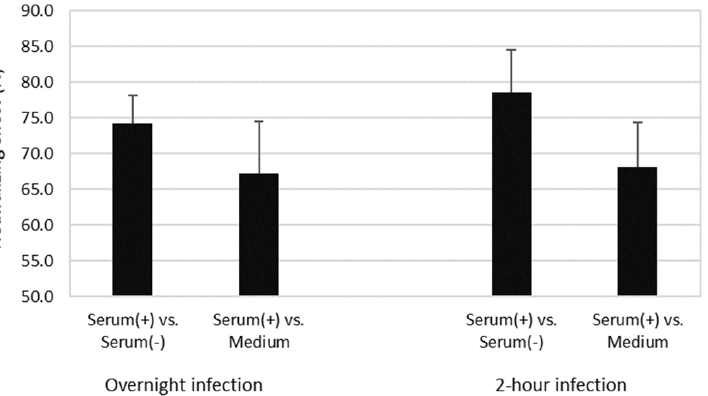
Figure 4. The neutralizing effects (percentage of EGFP+ cell reduction) of hyperimmunized sera compared to naïve sera or cell culture medium at MOI of 0.5 HAD 50 (infection inoculum: 50 µ L of ASFV in 250 µ L of serum or medium) using adherent PBMC isolated from a donor pig.